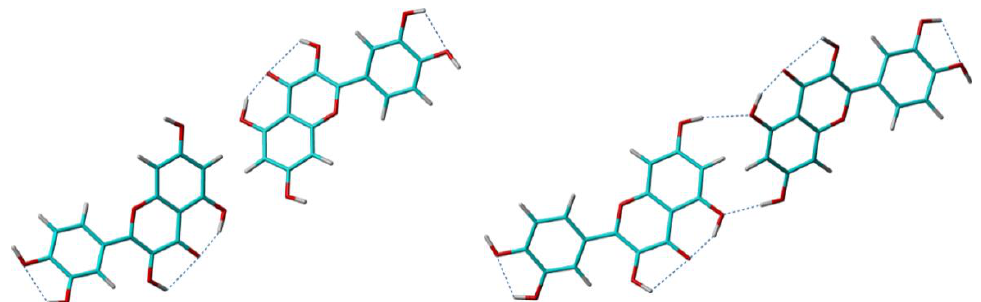
Figure 8. Intermolecular contacts of Quercetin molecules along the benzopyran rings depending on the conformation of the –O7-H hydroxyl in two crystal structure models of anhydrous Quercetin, Quer-1 ( left ), and Quer-2 ( right ).